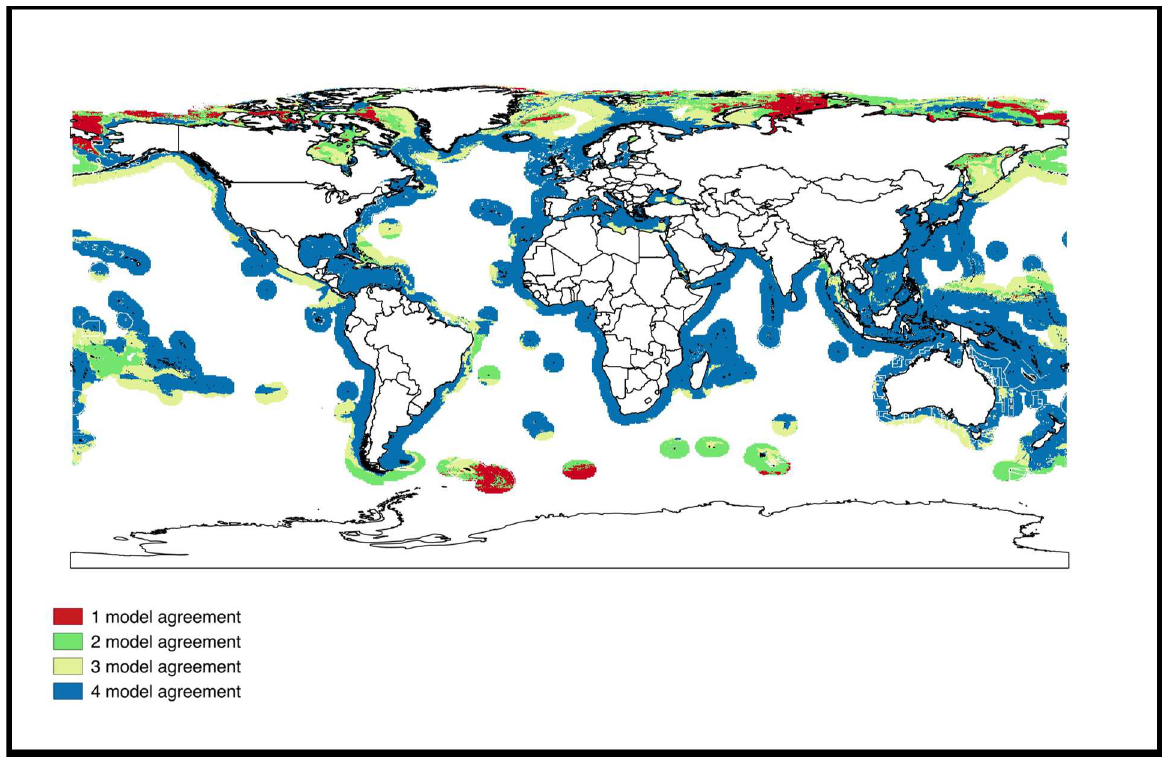
Fig 4. Predicted suitable marine area for mariculture and the agreement among SDMs. Blue—high agreement (4 models), Yellow—moderate agreement (3 models), Green—low agreement (2 models) and Red–very low agreement (1 model).